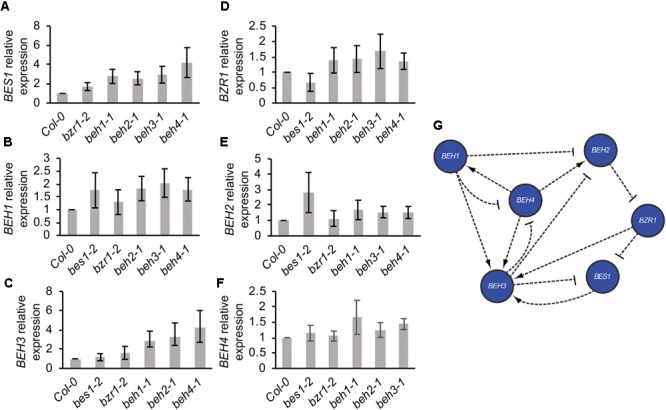
BZR/BEH family members engage in extensive regulatory cross-talk. Level of gene expression (mRNA) in mutant backgrounds was determined using qPCR for (A)
BES1, (B)
BEH1, (C)
BEH3, (D)
BZR1, (E)
BEH2, and (F)
BEH4. (G) Direct and indirect regulatory relationships among BZR/BEH family members were determined from results in (A–F). A regulatory relationship was called for a gene if a greater than a 2-fold expression difference between wild-type and mutant backgrounds was measured. Both positive (arrow) and negative (bar) regulatory relationships are indicated.